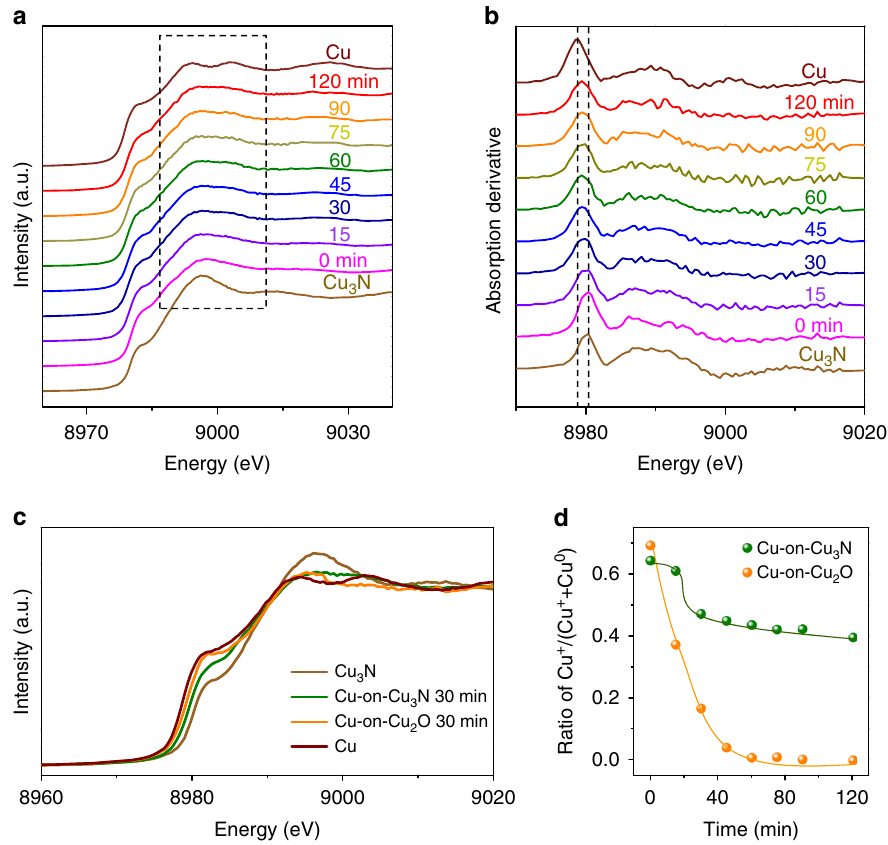
Fig. 3 In situ characterization of the structure and chemical state for the catalysts during CO 2 reduction. a Cu K-edge XAS spectra of the Cu-on-Cu 3 N catalyst as function of reaction time at − 0.95 V vs RHE. b The fi rst derivatives of the spectra in a . c In situ Cu K-edge spectra during the initial 30 min on the catalysts: Cu-on-Cu 3 N (green) and Cu-on-Cu 2 O (orange). Spectra of Cu (red) and Cu 3 N (yellow) are also listed as references. d Ratio of Cu + relative to the reaction time at − 0.95 V vs